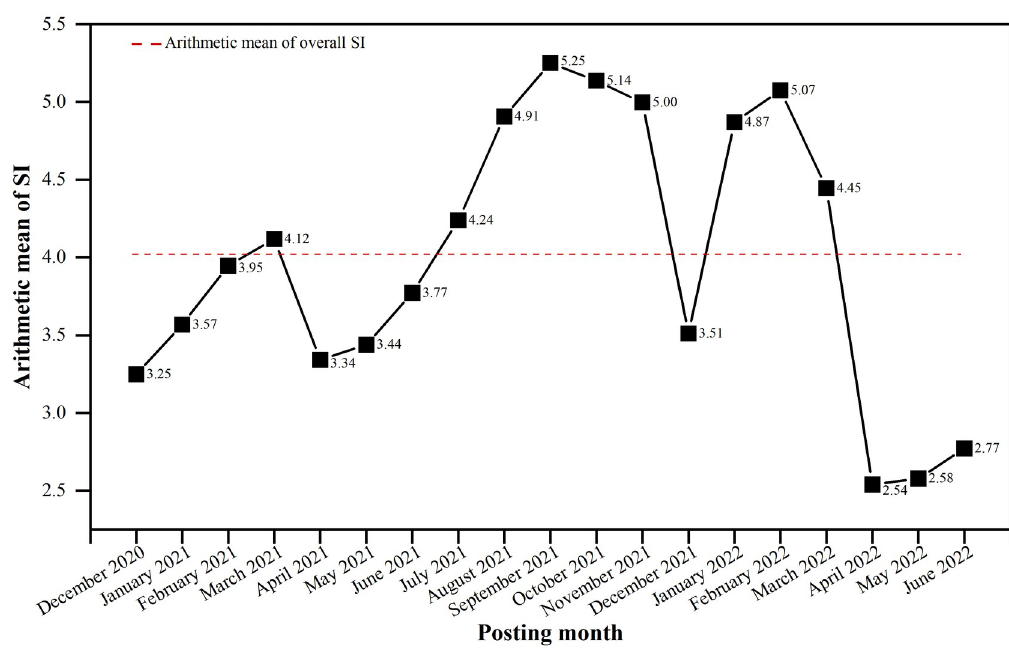
Fig 6. Monthly variation of arithmetic mean of SI.